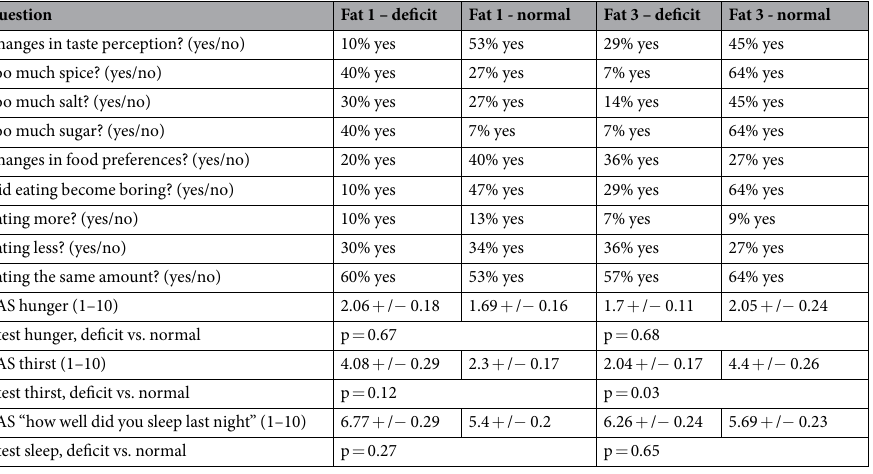
Table 2. Changes in taste, flavoring and eating pleasure after brain injury/hunger, thirst, and degree of tiredness. For the latter three measures we applied visual analogue scales (VAS) ranging from 0 to 10. VAS ratings between patients with a deficit in taste perception and those not presenting such a deficit were applied to unpaired